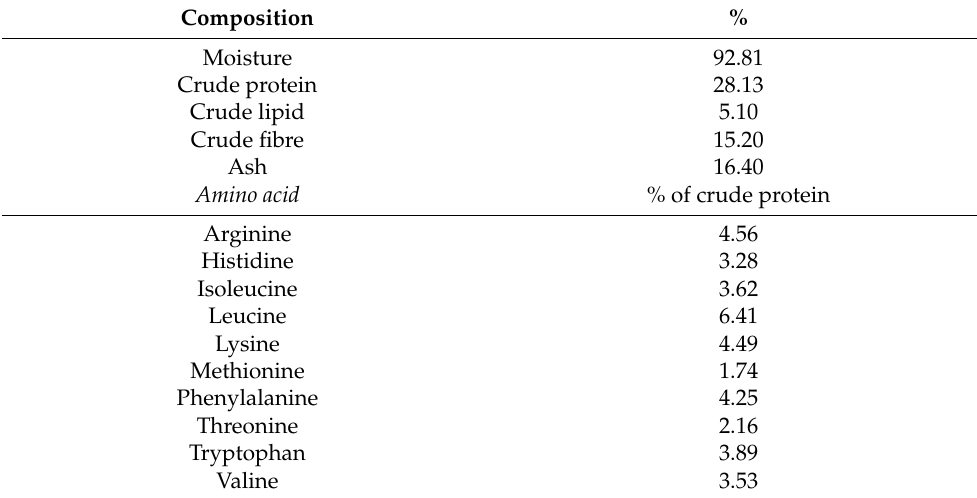
Table 3. Proximate composition (%) and amino acid profile (g/100 g) of duckweed meal used in the